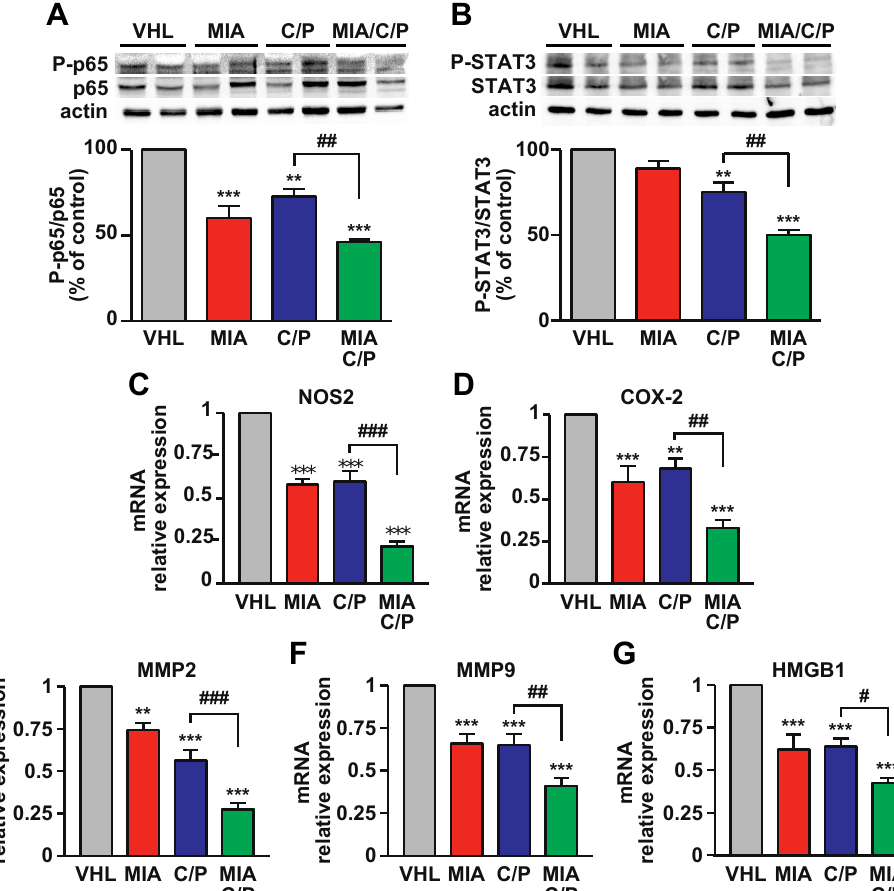
Figure 4. Anti-inflammatory action of MIA-690 in combination with chemotherapeutic drugs in PM tissues. Representative Western blots for phosphorylated NF-kB (P-p65) ( A ) and STAT3 (P-STAT3) ( B ) (top) in MSTO-211H xenografts of mice treated with vehicle (VHL), MIA-690, cisplatin and pemetrexed (C/P) or the combination of MIA/C/P. Blots were reprobed with respective total antibodies for normalization and for actin (bottom). Results, expressed as percentage of control (VHL), are means ± SEM. ** p < 0.01, *** p < 0.001 vs. VHL; ## p < 0.01 by one-way ANOVA and Tukey’s post hoc test ( n = 4 for each group). Real-time PCR analysis for iNOS ( C ), COX-2 ( D ), MMP2 ( E ), MMP9 ( F ) and HMGB1 ( G ) mRNA in PM tumors, normalized to 18S rRNA (means ± SEM). ** p < 0.01, *** p < 0.001 vs. VHL; # p < 0.05, ## p < 0.01, ### p < 0.001 by one-way ANOVA and Tukey’s post hoc test ( n = 7 for each group).